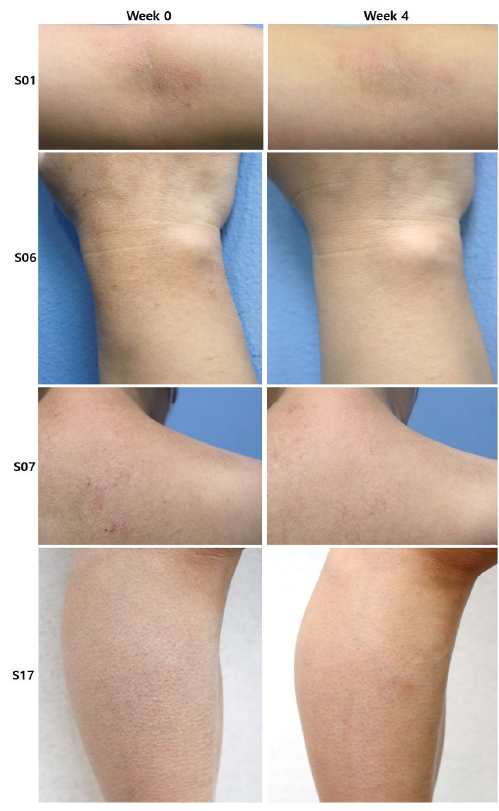
Figure 2. Images showing improvement of skin hydration and erythema after four weeks of H.ECM TM liposome ‐ containing emollient application (subject examples S01, S06, S07, and S17). 2.3. In Vitro Evaluation of H.ECM TM Liposome and Its Efficacy on Skin Barrier Function and Wrinkles To measure if H.ECM TM liposome ‐ containing emollient was cytotoxic, an MTT assay was performed using a mouse macrophage (RAW 264.7), human epidermal keratinocyte (KC), and human dermal fibroblast (HDF) cells. All cell lines were treated with 0.01%, 0.05%, 0.1%, 0.5%, and 1% H.ECM TM liposomes, and the results of the MTT assay are shown in comparison with those of the control cells. Additionally, the cytotoxicity of lip ‐ opolysaccharide (LPS; 0.5–50 μ g/mL) was evaluated in HDF cells. The results of the MTT assay for each cell line are shown in Supplementary Figure S1. Based on the results, 0.05% H.ECM TM liposome treatment was used in the real ‐ time quantitative reverse transcription polymerase chain reaction (qRT ‐ PCR) and immunofluorescence staining experiments. Gene expression levels were evaluated using qRT ‐ PCR. The expressions of the HAS3 and AQP3 genes involved in skin hydration were compared with those in response to treatment with 1 μ M retinoic acid (positive control) using KCs. The expression levels of HAS3 and AQP3 in the 0.05% H.ECM TM liposome treatment group increased significantly